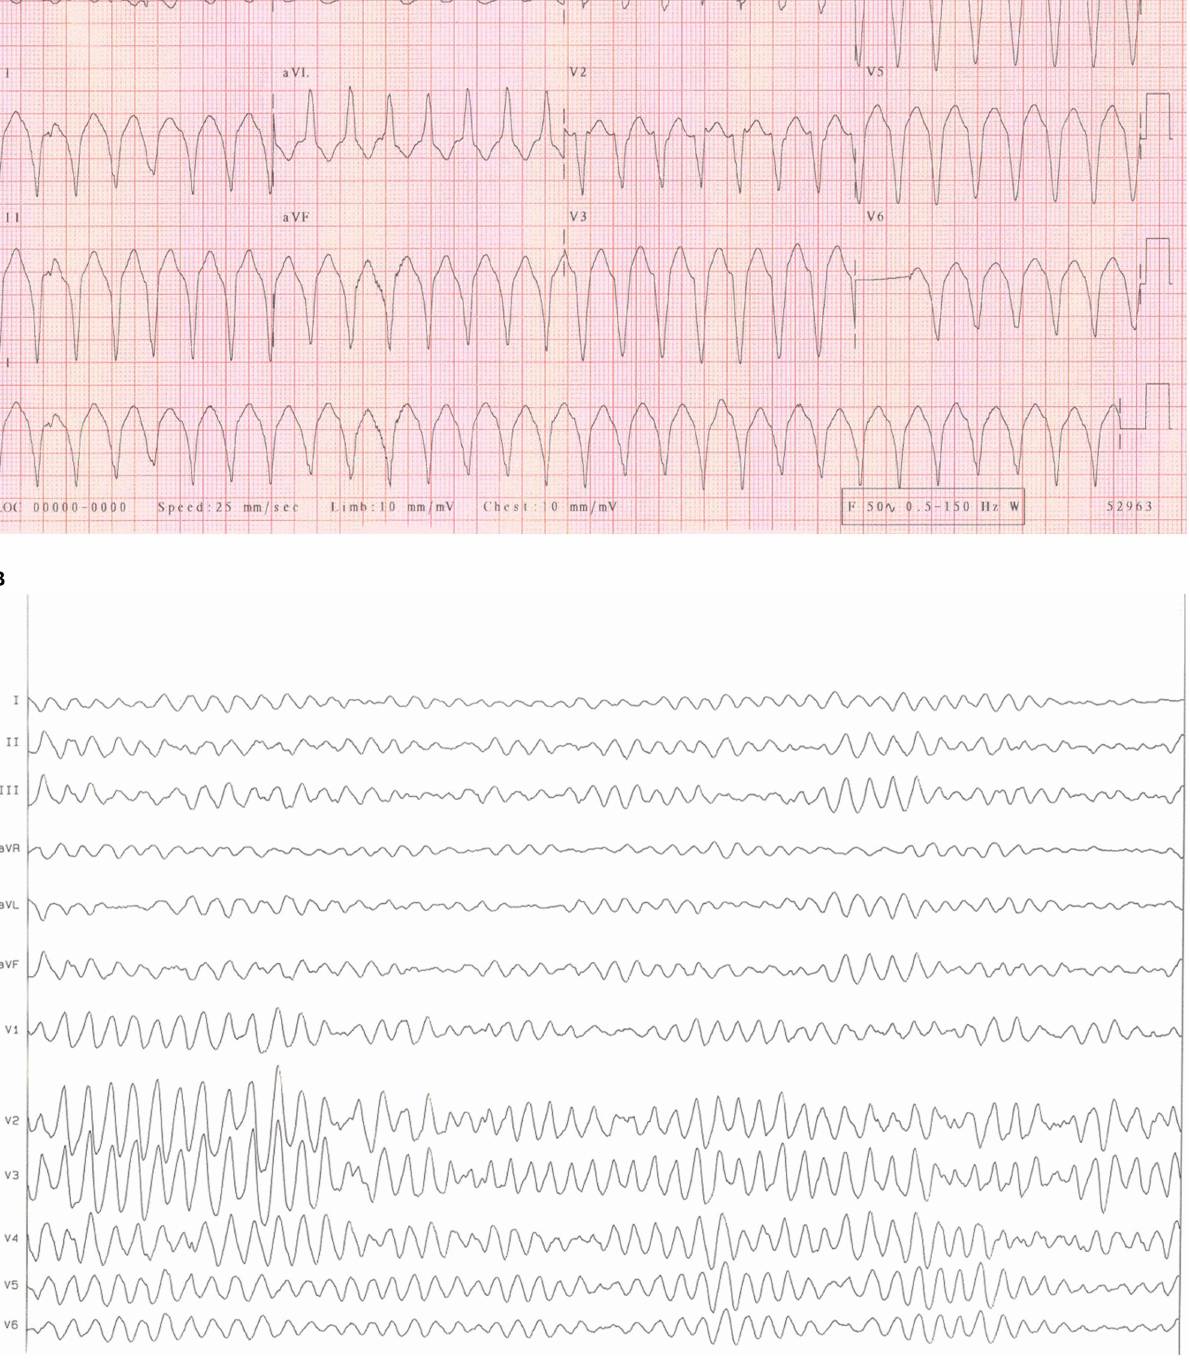
FIGURE 2 | (A) An ECG of ventricular tachycardia. An example of an ECG from a patient with sustained monomorphic ventricular tachycardia. It is characterized by regular, broad QRS complexes of similar morphology often over 100 bpm. (B) An ECG of Ventricular fibrillation. An example of an ECG from a patient with ventricular fibrillation. It is characterized by rapid, erratic ventricular activity as the heart fibrillates rather than pumps effectively. This rhythm quickly degenerates into cardiac arrest.